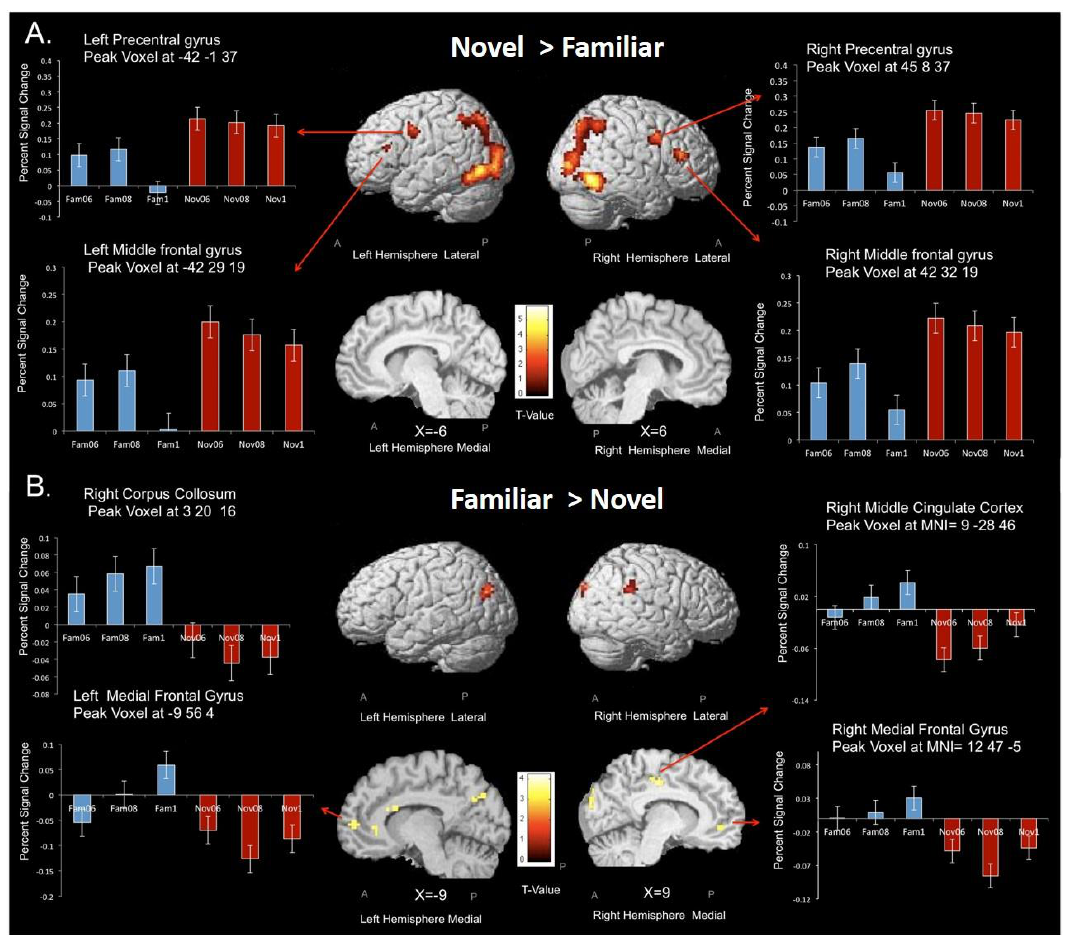
Figure 6. Regions demonstrating greater activation for the (a) novel CS > familiar CS contrast across all eighteen participants ( p < 0.001 uncorrected, minimum cluster size 10 voxels). For the two top images, activation is overlaid on the lateral surfaces of the cortex separately for each hemisphere (the image on the right side of the figure depicts the right hemisphere whereas the image on the left side of the figure depicts the left hemisphere). The bottom two images show activation in the medial surface of the cortex. (b) Shows the regions demonstrating greater activation for the familiar CS > novel CS contrast across all participants ( p < 0.001, uncorrected, minimum cluster size 10 voxels). For the two images, the top activation is overlaid on the lateral surfaces of the cortex separately for each hemisphere, for both figure (a) and (b), the color bar represents the t-value where yellow regions correspond to higher t-values and a larger effect size. The bar graphs on the sides of each figure depict percent signal change for the novel and familiar CS that were shown for the peak voxels.